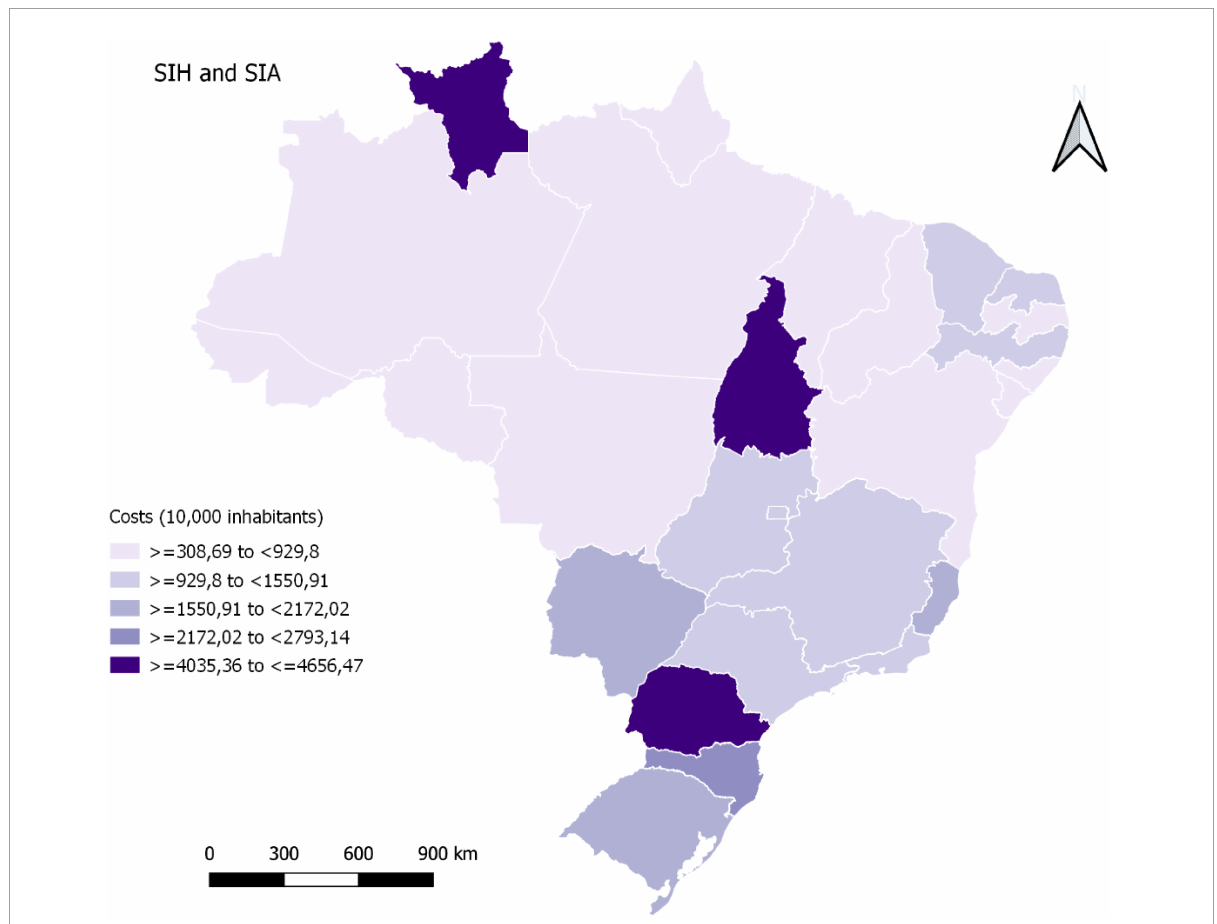
FIGURE1 Financial costs in the treatment of non-transmissible chronic diseases (NCDs) attributed to the consumption of sugar-sweetened beverages (SSBs), in international dollars (US$) and in the federative units per 10,000 inhabitants, Brazil, 2019.